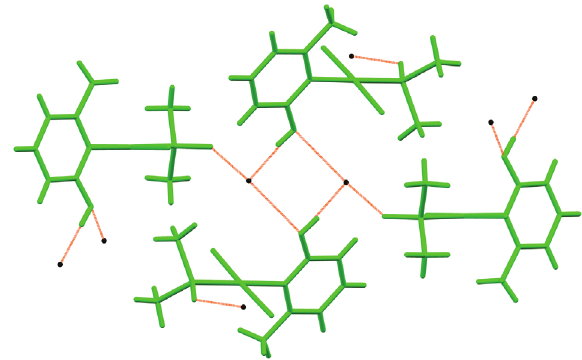
Fig. 3. Hydrogen-bonding pattern in trans - [ PtCl (dmso)(Hmhp) ] · 2 H O. The involved functions are: hydroxyl groups, dimethyl sulfo- 2 O molecules. Color code: black spheres xide oxygen atoms and H 2 = H O molecules of crystallization, green = complex 2